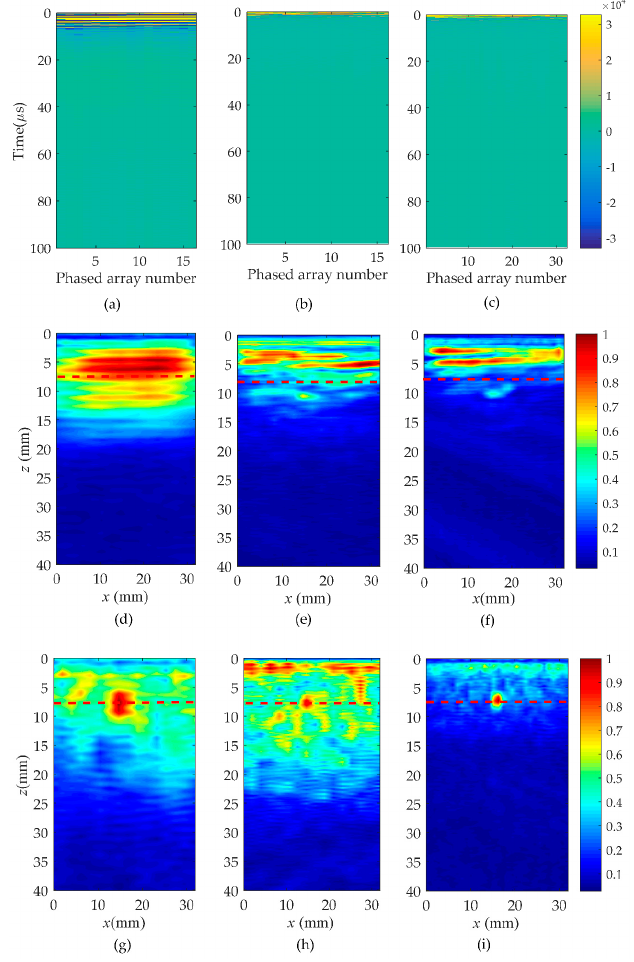
Figure 7. Comparison of B-scan and wavenumber imaging in three cases in rail A. Case one: ( a ) is pulse-echo responses, ( d , g ) are the images of the full matrix, h i , j ( t ) and f i , j ( t ) ; Case two: ( b ) is pulse-echo responses, ( e , h ) are the images of the full matrix, h i , j ( t ) and f i , j ( t ) ; Case three: ( c ) is pulse-echo responses, ( f , i ) are the images of the full matrix, h i , j ( t ) and f i , j ( t )